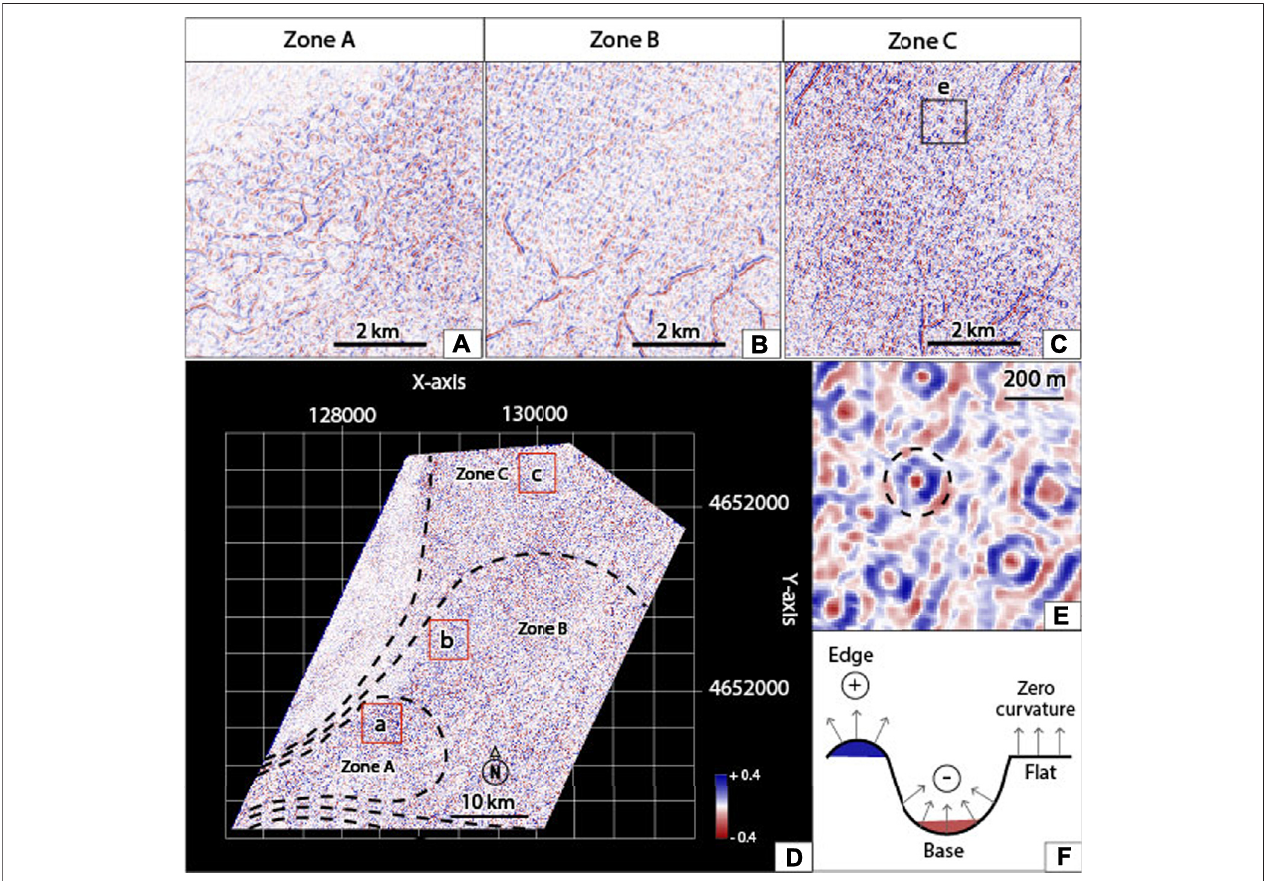
FIGURE12| Characteristics ofpaleo-pockmarks from thecurvaturedip map for zones (A) A, (B) B, and (C) C(locationsinthe red rectangles).Black-dashed lines are the boundaries of the three paleo-pockmark zones (D) . Characteristics of paleo-pockmarks are shown in a dashed circle (blue colour is pockmark edge, and red colour is pockmark base) (E, F)